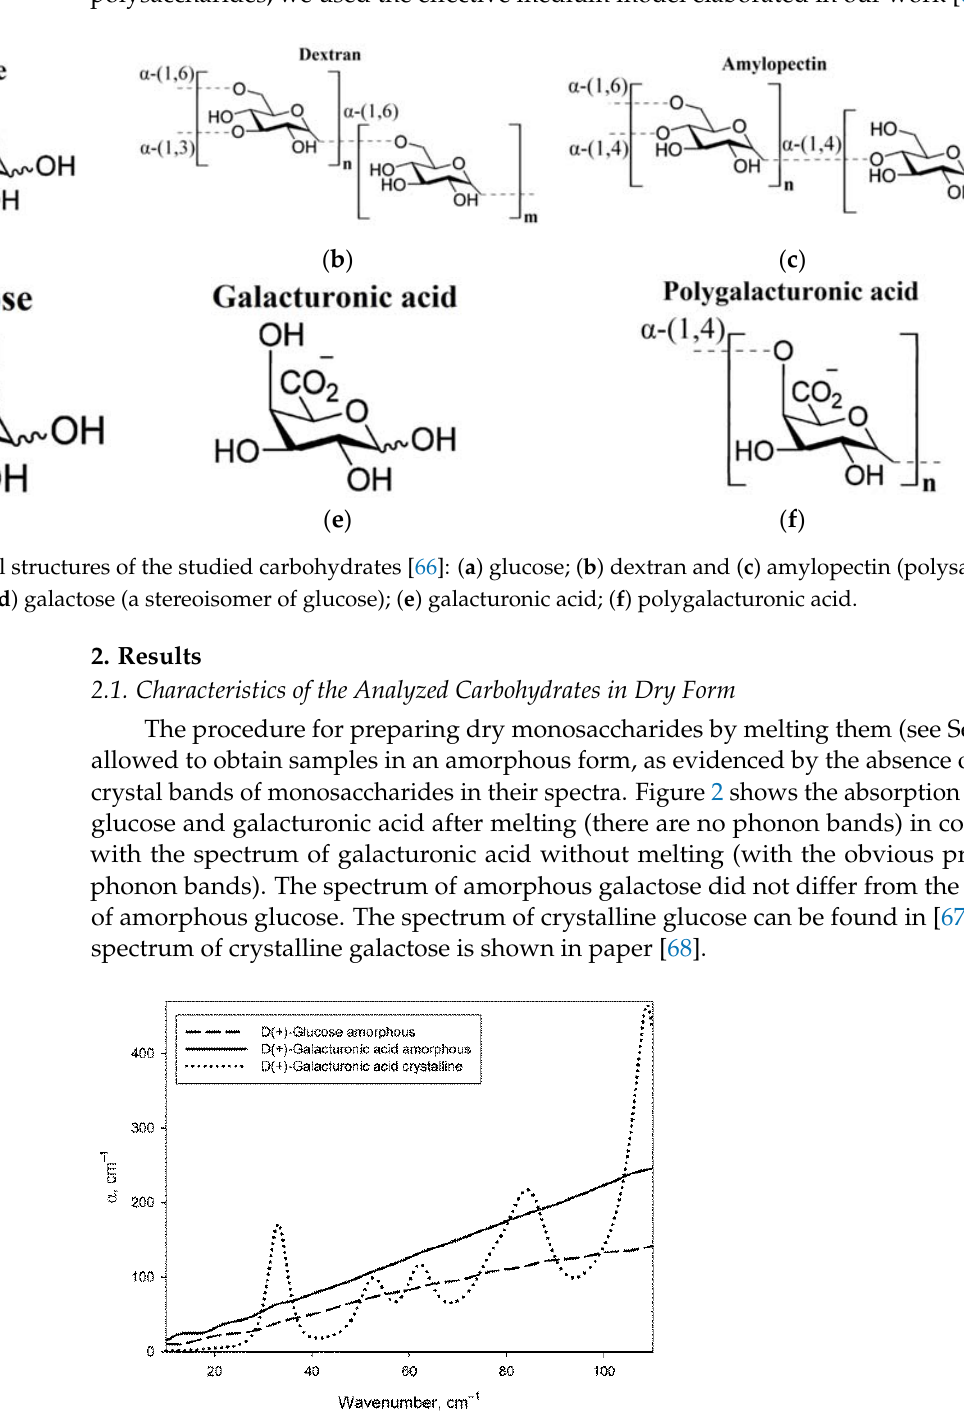
Figure 2. Absorption coefficient spectra of amorphous samples of glucose and galacturonic acid, as well as of crystalline galacturonic acid.